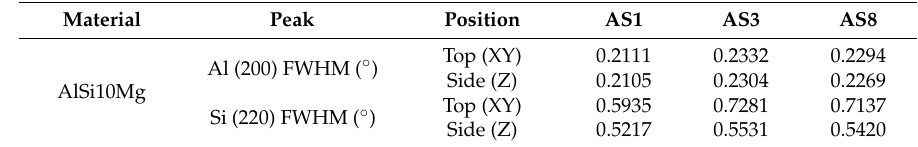
Table 3. The average FWHM of Al and Si peaks according to the XRD phase pattern of the as-built AlSi10Mg samples.